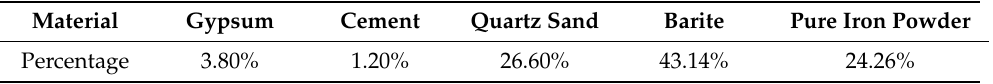
Table 8. Proportions of components in the model material similar to the actual samples from the